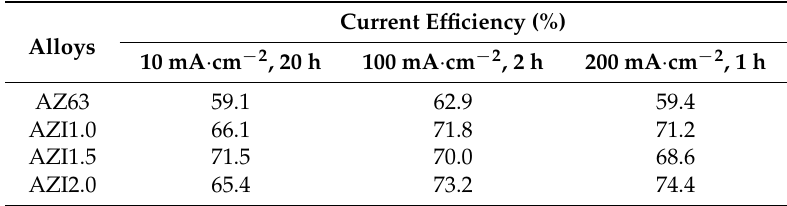
Table 5. Current efficiencies of AZ63 and AZI alloys under different